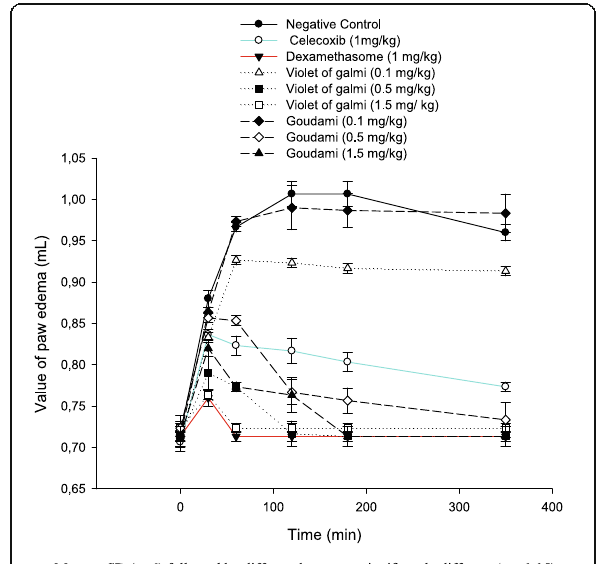
Fig. 1 Effect of variety and concentration of aqueous extracts of onion towards hind paw edema in carrageenan induced acute inflammation. Means ±SD ( n = 6) followed by different letters are significantly different ( p < 0.05) as determined by Duncan ’ s multiple range test